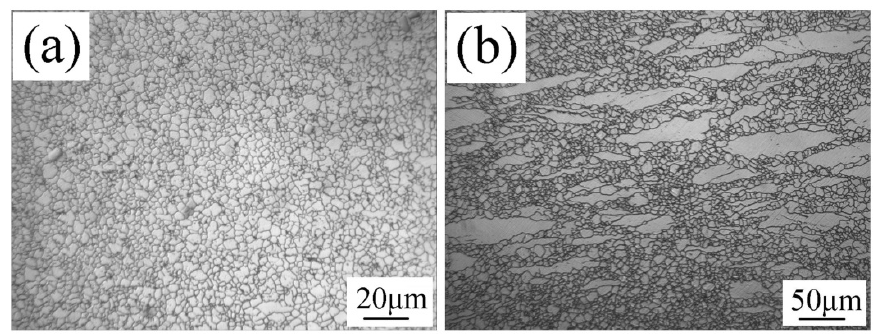
Figure 13. OIM of microstructure with an effective strain of 1.5: ( a ) 1010 ° C, ( b ) 1040 ° C.